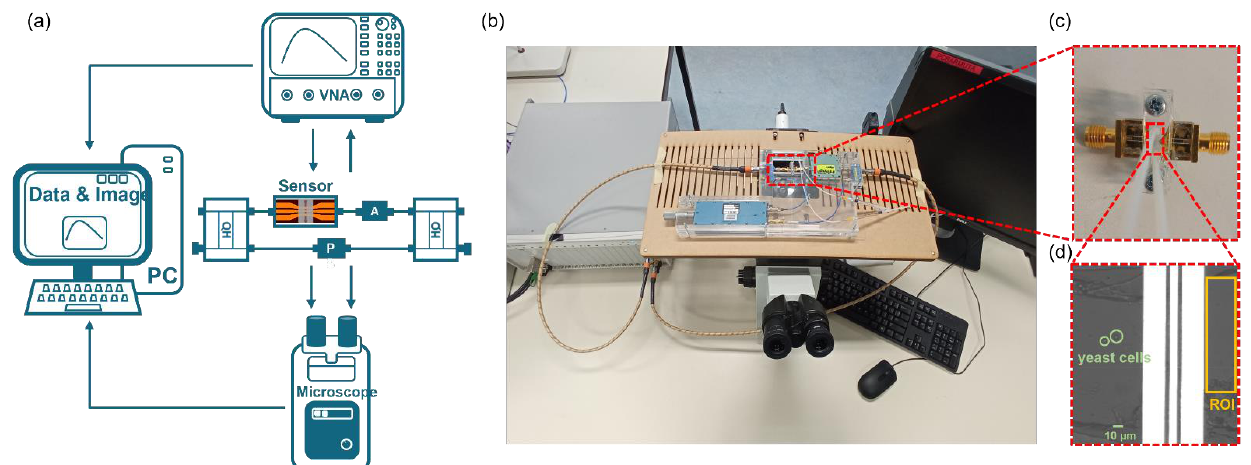
Figure 1. The schematic of the measurement system of the proposed microwave interferometric cytometry and the designed microfluidic sensor. ( a ) the schematic and ( b ) the picture of the measure- ment system setup, including the proposed microwave interferometric cytometry, VNA, microscope, and computer; ( c ) The designed co-planar waveguide (CPW) sensor with tapering structure and microfluidics on top (a straight channel with one inlet and one outlet); ( d ) The microscope image of two yeast cells (marked inside the green circles) approaching the CPW sensor (the bright CPW structure consisting of 3 parallel electrodes) in the microfluidic channel. The orange rectangular shows the region of interest (ROI) for microscope image intensity calculation.